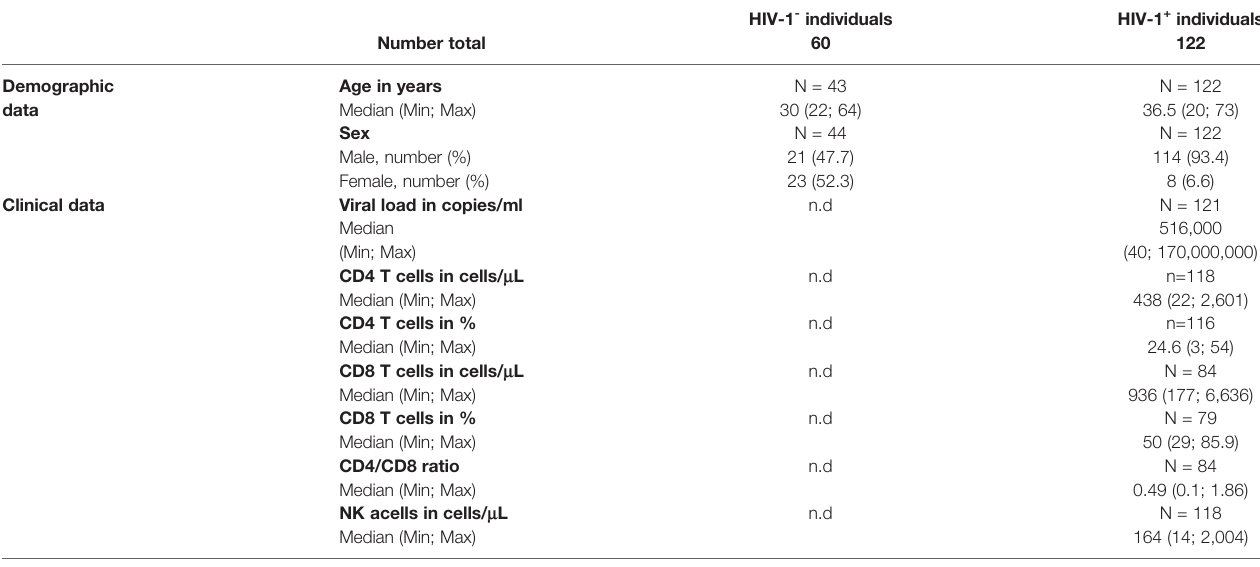
TABLE 3 | Demographic and clinical pro fi le of HIV-1 - and HIV-1 +